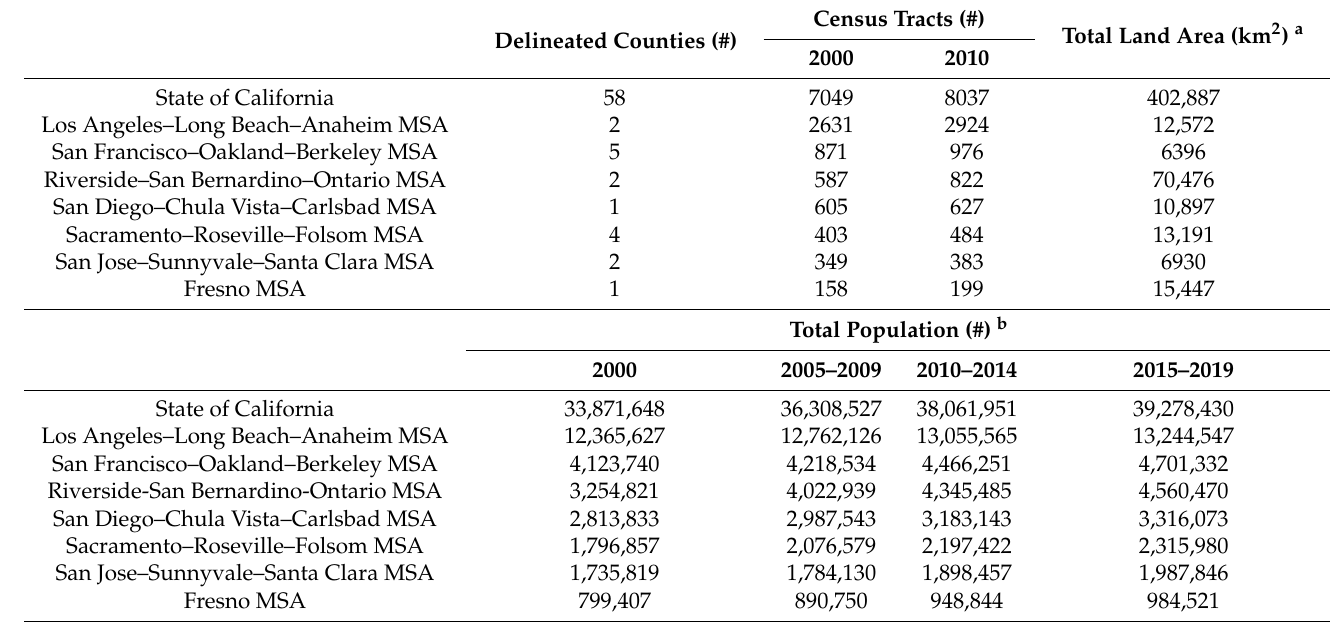
Table 2. Geographic and population characteristics of the study